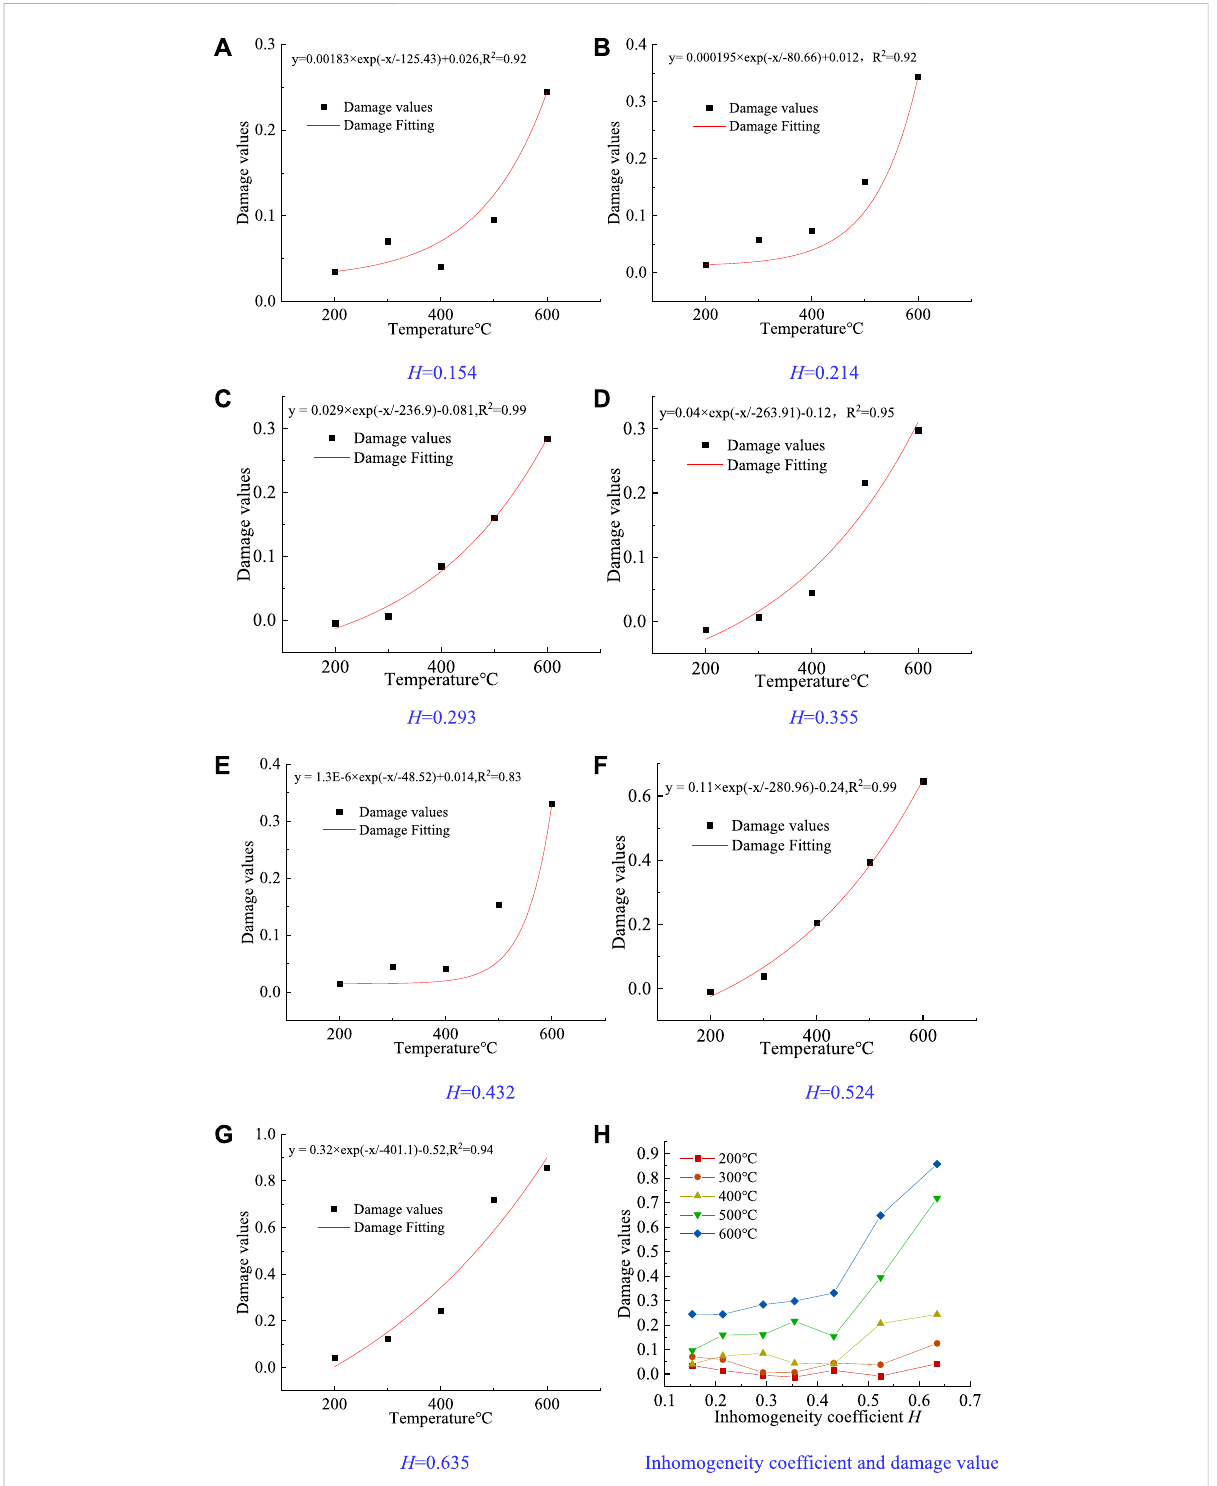
FIGURE 11 Relation between inhomogeneity coef fi cient and temperature damage value. (A) H = 0.154 damage value curve. (B) H = 0.214 damage value curve. (C) H=0.293damagevaluecurve. (D) H=0.355damagevaluecurve. (E) H=0.432damagevaluecurve. (F) H=0.524damagevaluecurve. (G) H = 0.635 damage value curve. (H) Inhomogeneity coef fi cient and damage